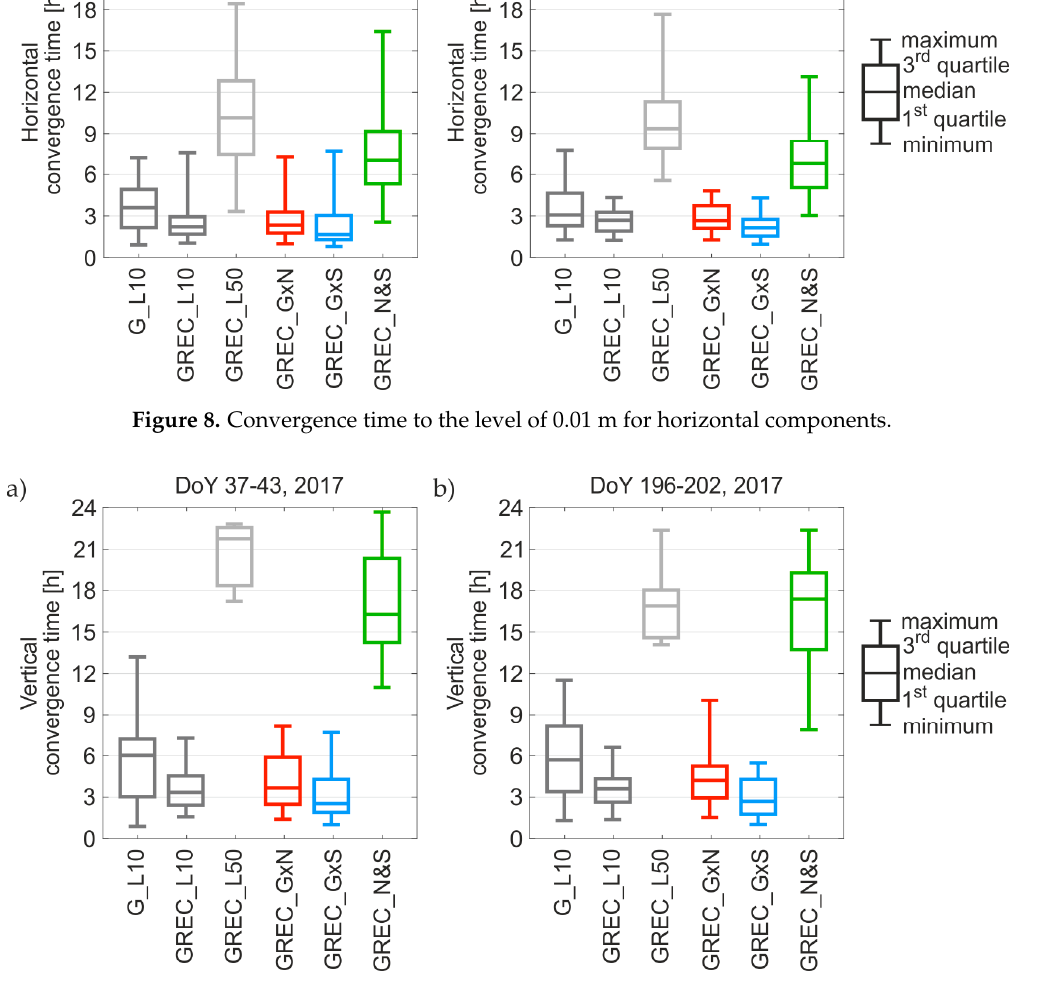
Figure 9. Convergence time to the level of 0.01 m for the vertical component. Table 7. Mean convergence time in hours to reach 0.01 m level for all of the stations during both test periods.